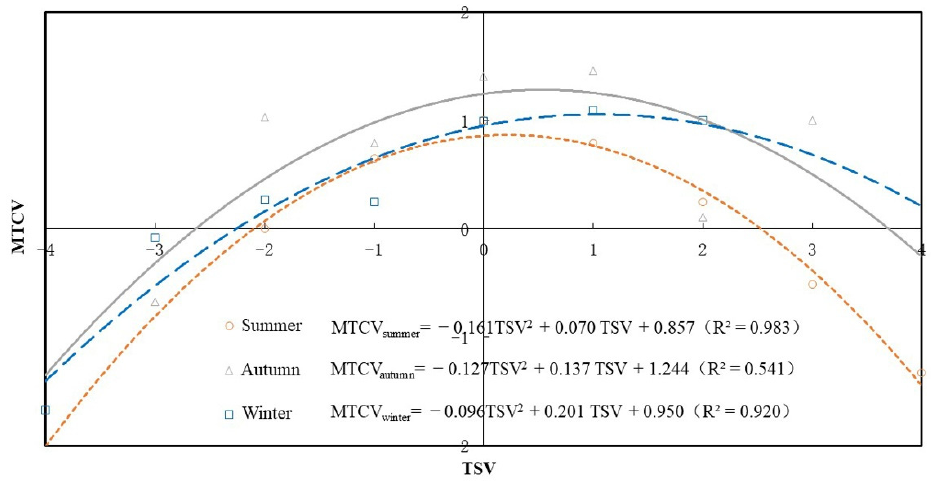
Figure 7. The relationships between MTCV and TSV in the summer, autumn, and winter.